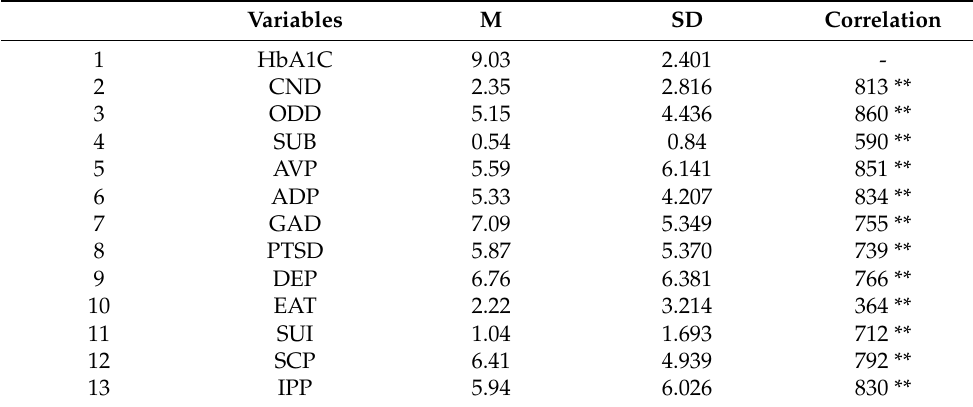
Table 3. Correlation between HbA1c value and the APS–SF subscales (Spearman’s rho).